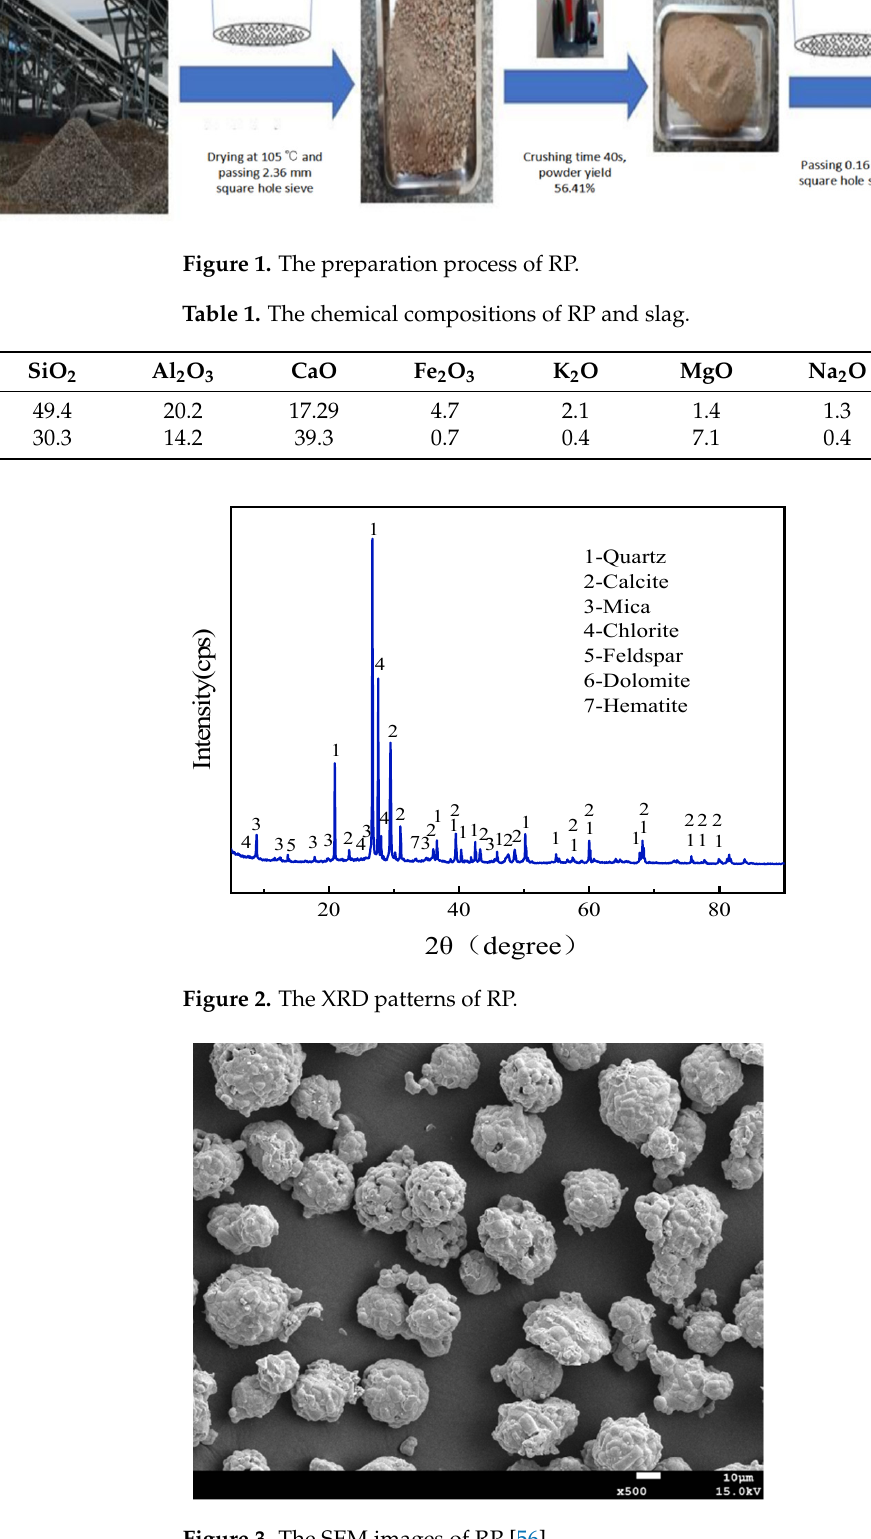
Figure 3. The SEM images of RP [56].